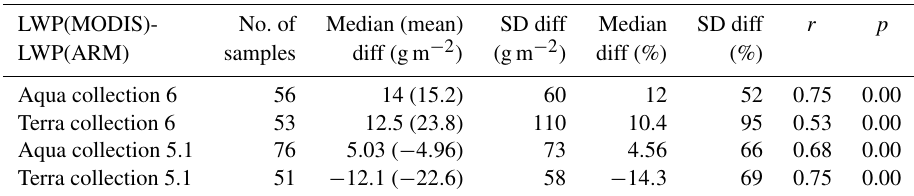
Figure 3. Scatterplots of MODIS liquid water path (LWP) versus ARM liquid water path. The two top subfigures contain data from the C6 dataset, while the bottom subfigures contain data C5.1. The colouring of the circles is according to solar zenith angle. The lines in the figures are 1:1 lines. Table 5. Median and mean differences, standard deviations of the differences, correlation coefficients and p values between MODIS and ARM liquid water path